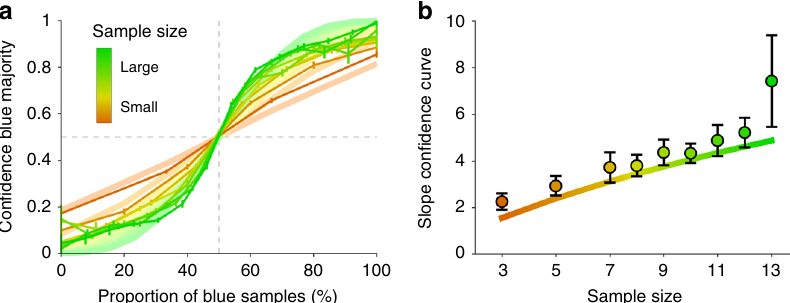
Fig. 2 Human con fi dence estimates vary with sample size as predicted by probabilistic inference. a Con fi dence in a blue majority increases with the proportion of blue samples (solid lines), and it does so more steeply the larger the sample size is (color coded). Optimal model is represented in light colors. b The slope of the con fi dence curve in a increases with sample size. Participants feature a quantitatively similar increase as the optimal model (solid line). Error bars indicate SEM across